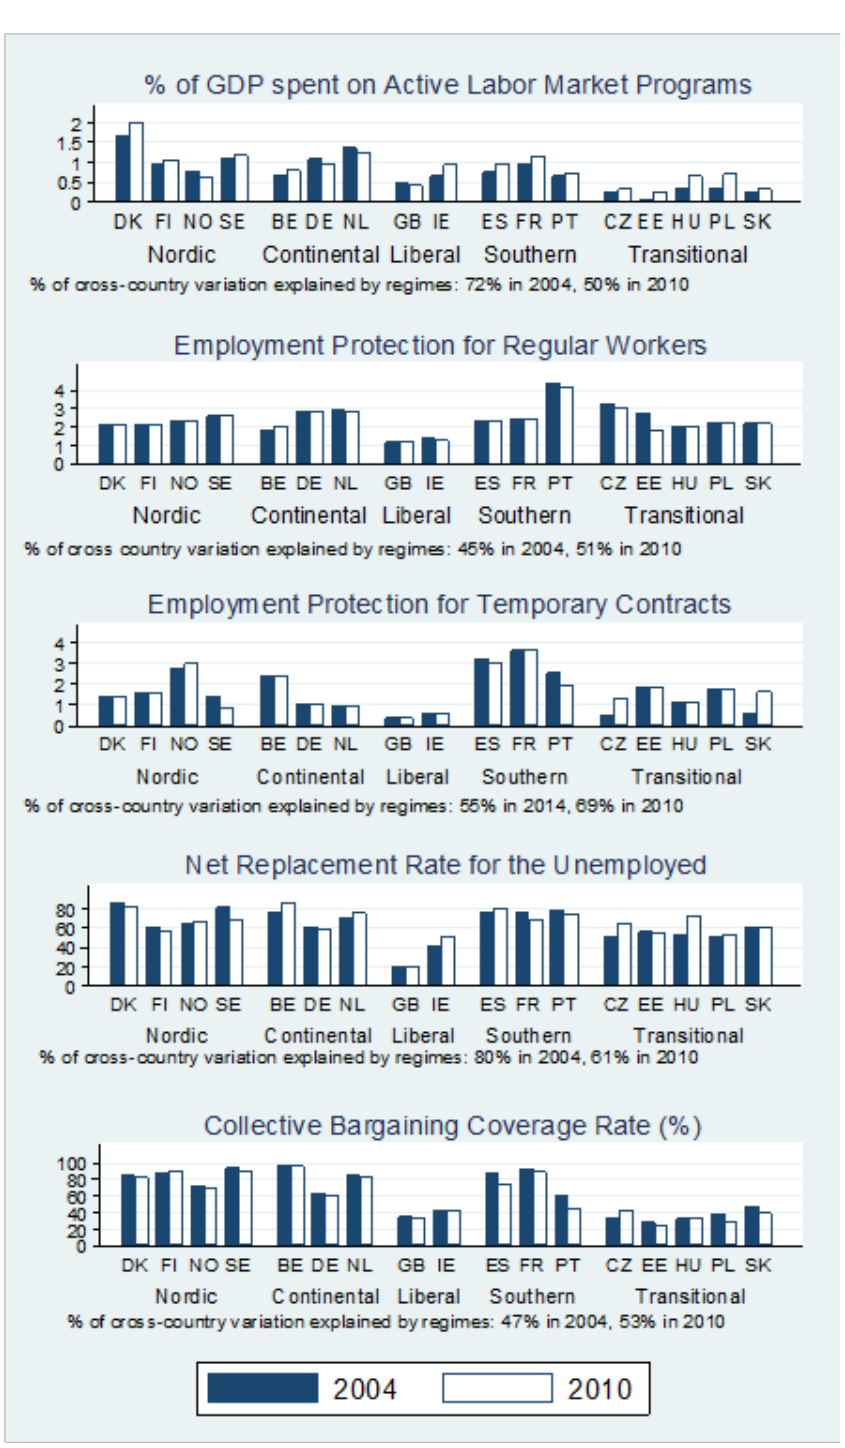
Figure A1. Macro indicators and countries. Note: Nordic countries include Denmark, Finland, Norway, and Sweden. Continental countries include Belgium, Germany, and the Netherlands. Liberal countries include Great Britain and Ireland. Southern countries include Spain, France, and Portugal. Transitional countries include the Czech Republic, Estonia, Hungary, Poland, and Slovakia. Data source: European Social Survey.